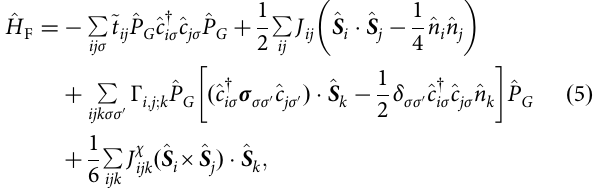
different behaviours between ω red-detuned or blue-detuned from U .